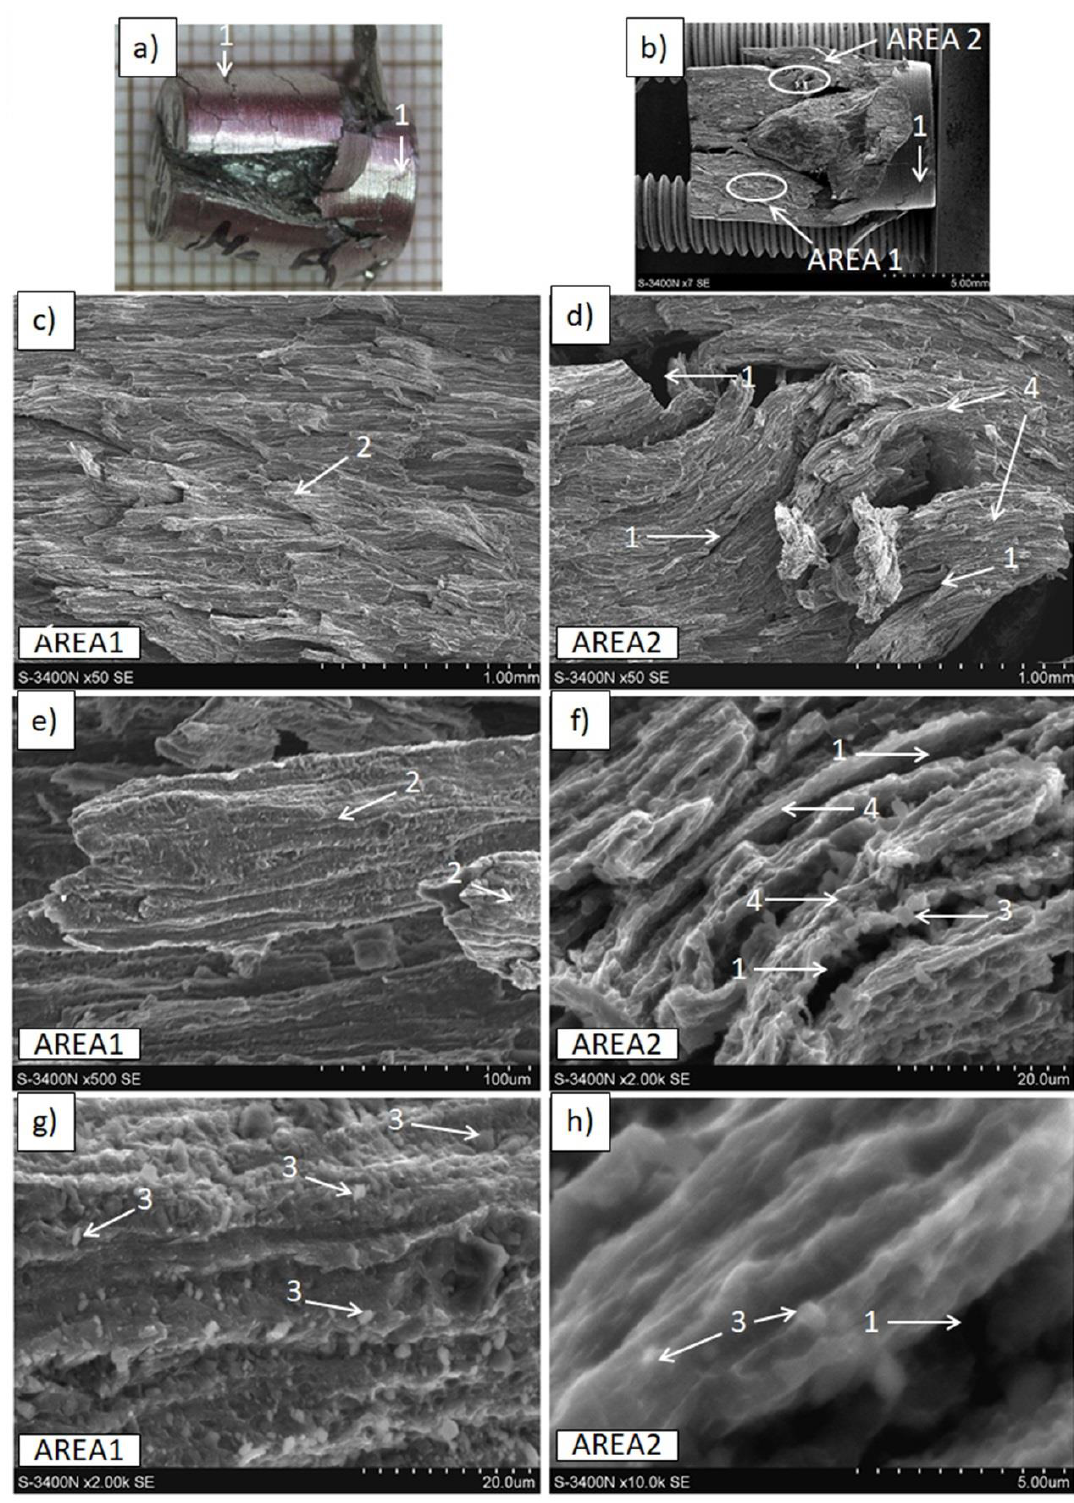
Figure 14. Decohesion effects in the Mg(P) rod after compressive strength test. View of sample ( a , b ), fracture of cone and cup type with cracks (1) at the machined surface. SEM micrographs of fracture surface: ( c , e , g ) splits (2) of deformed fine grained metal with dispersed oxide particles (3), and ( d , f , h ) metal bands (4) with refined oxides (3) separated by cracks (1).